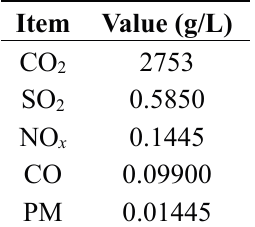
Table 5. Emission factors of